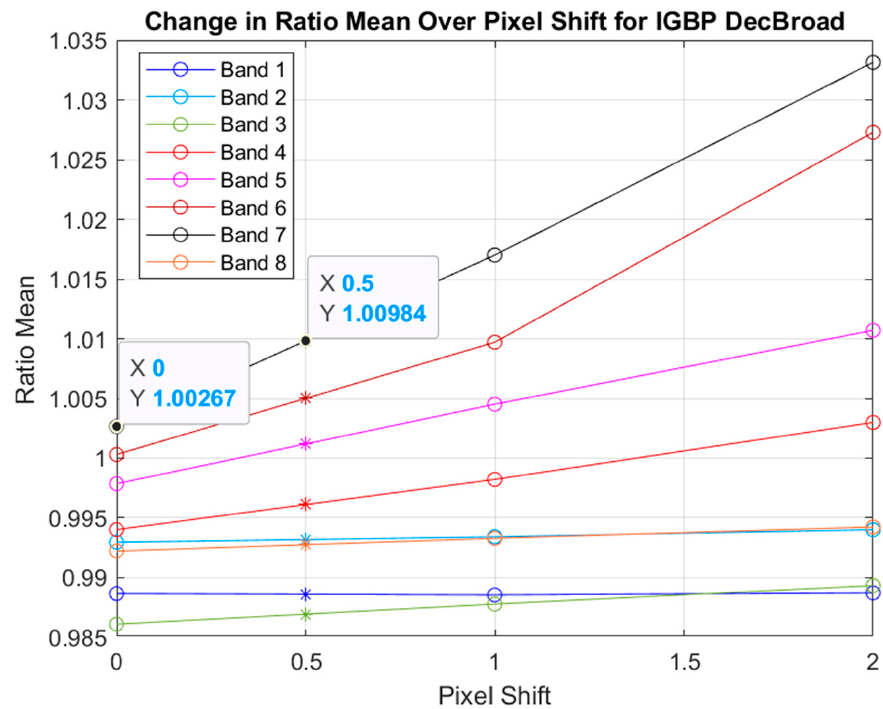
Figure 17. Geometric bias plot. Pixel shift 0 has an uncertainty of ~1/3 pixel, so the bias introduced at that value needed to be determined. The ratio value between 0 and 1 at 0.5 was interpolated, denoted by *. Since the bias at pixel 0.5 is likely larger or equal to the bias introduced at ~1/3, that value was used to overestimate the bias as a worst-case scenario. The difference between 1.00984 and 1.00267 was determined to be the geometric bias on the SWIR2 band, being